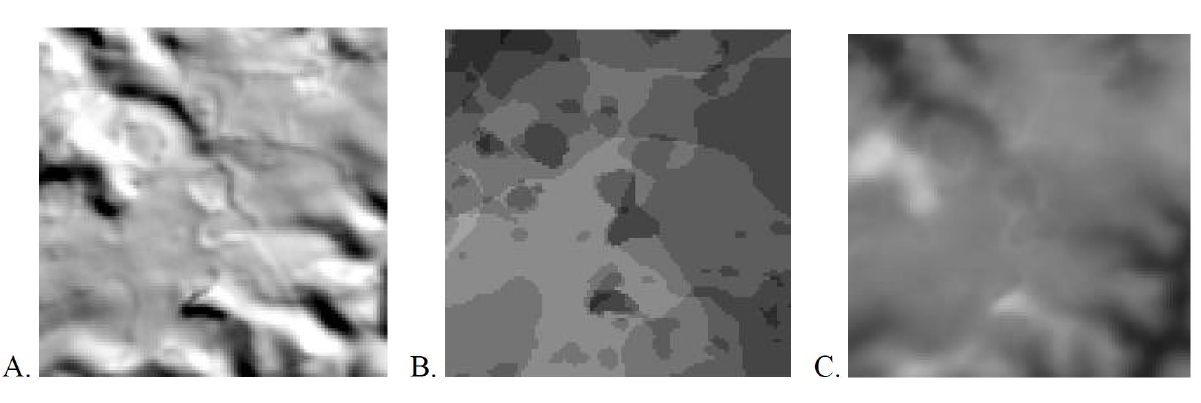
Figure 5. Example of “mole-run” artifacts; (A) shaded relief, (B) clear relation to the stack number boundaries, (C) less obvious in ASTER GDEM image (originally appeared in